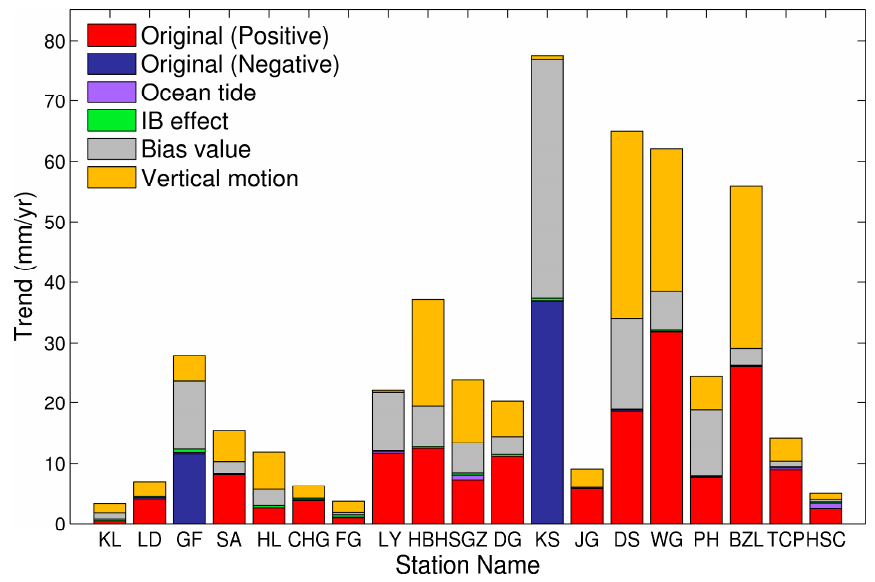
Figure 3. Effects of each geophysical and datum shift correction on the sea-level trends around Taiwan using tide gauges covering 1993–2015.